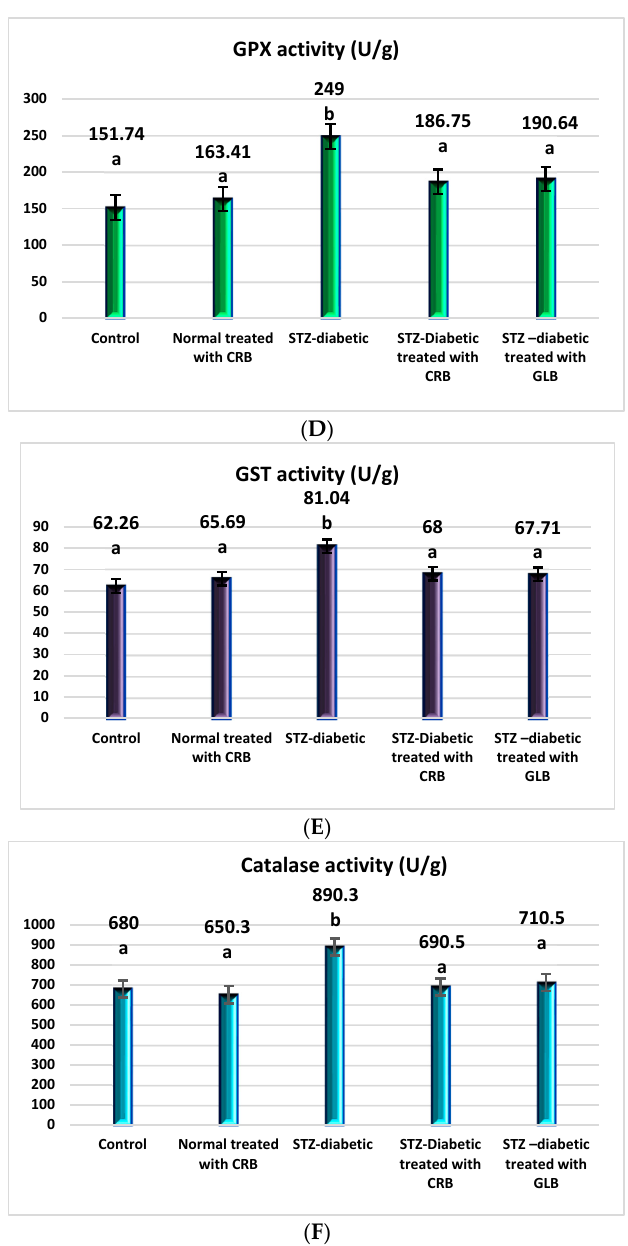
Figure 3. Effect of the n-butanol fraction of Colvillea racemosa total extract (CRB) oral administration on oxidative stress markers in Streptozotocin (STZ)-induced diabetic rats; GSH level ( a ), nitric oxide level ( b ), lipid peroxidase level ( c ), GPX activity ( d ), GST activity ( e ), and catalase activity ( f ). Results are displayed as means ± S.D. (measured in triplicate; n = 3). Means with different letters are significantly different ( p < 0.05).